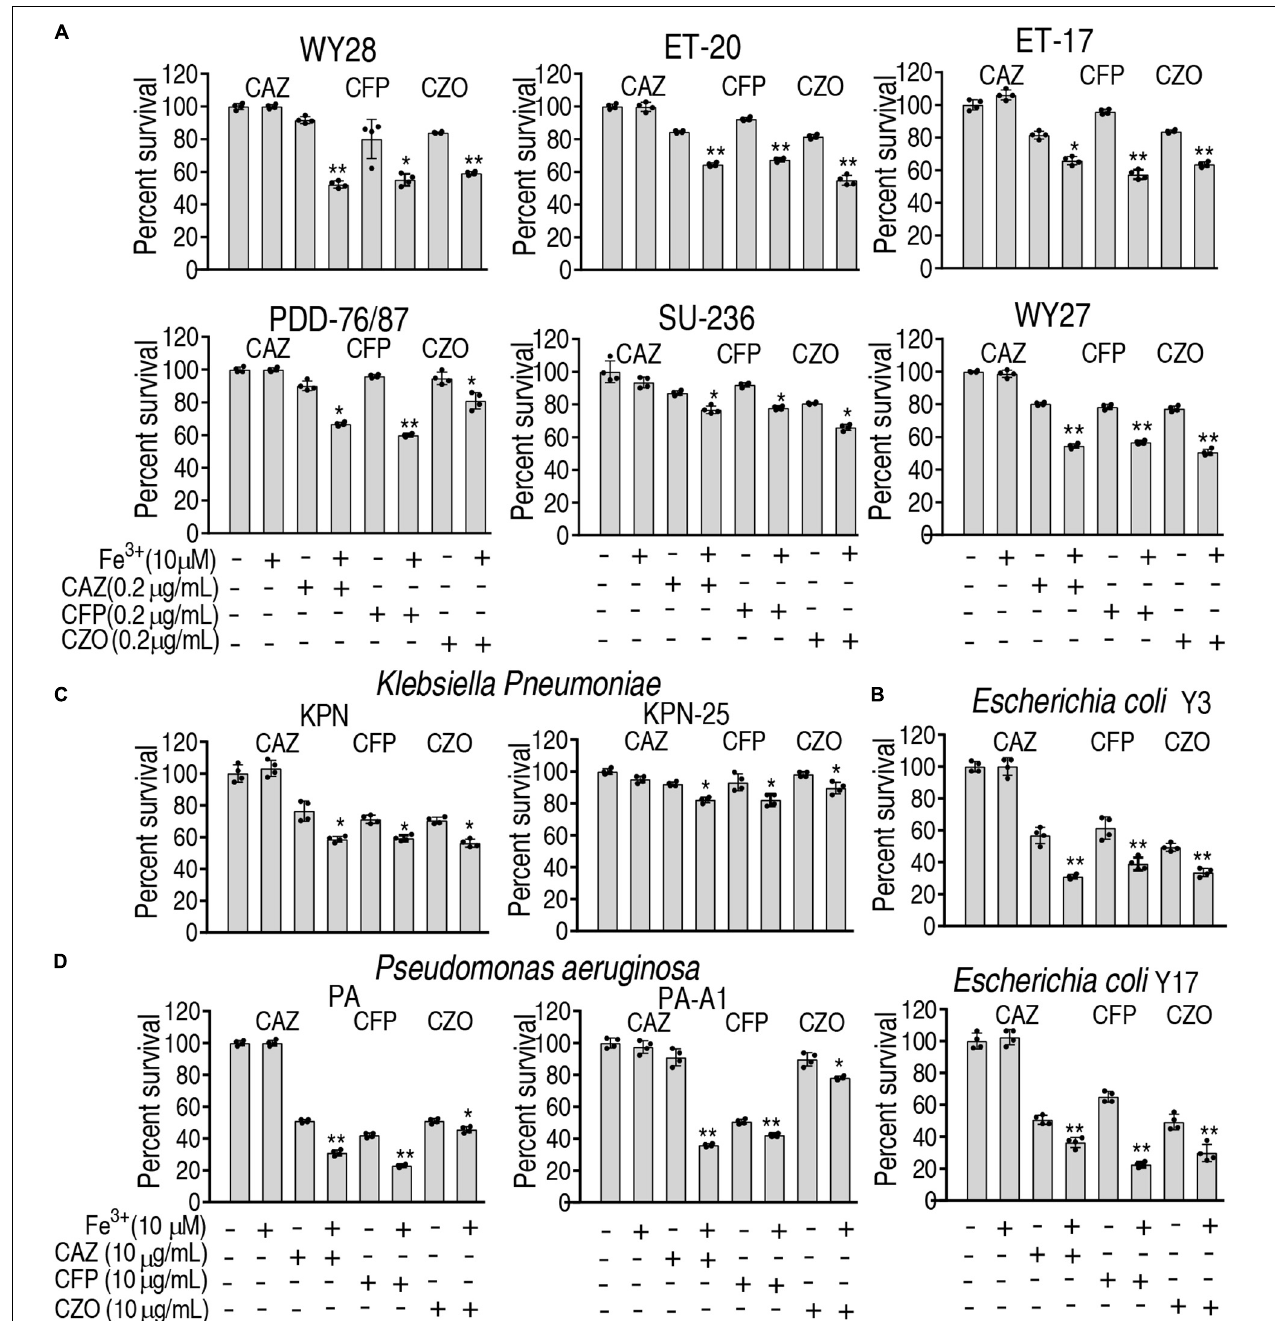
FIGURE 7 | Percent survival of clinically isolated pathogens in the presence of Fe 3 + and ceftazidime, cefoperazone, or cefazolin. (A) E. tarda . (B) E. coli . (C) K. pneumoniae. (D) P. aeruginosa .